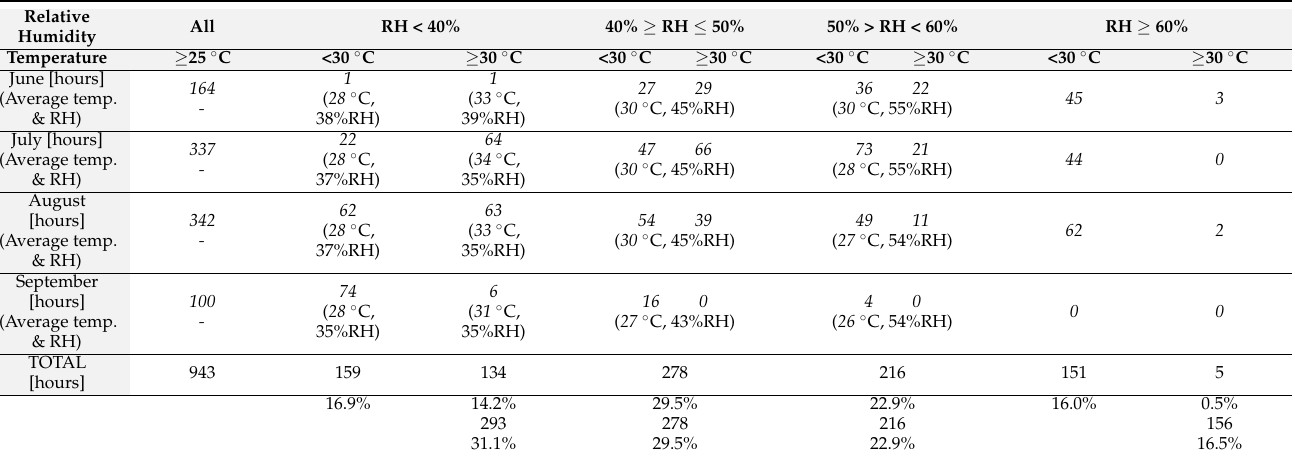
Table 6. Time summary of relative humidity for temperatures above 25 ◦ C in June, July, August, and September 2021 (data processed from reference